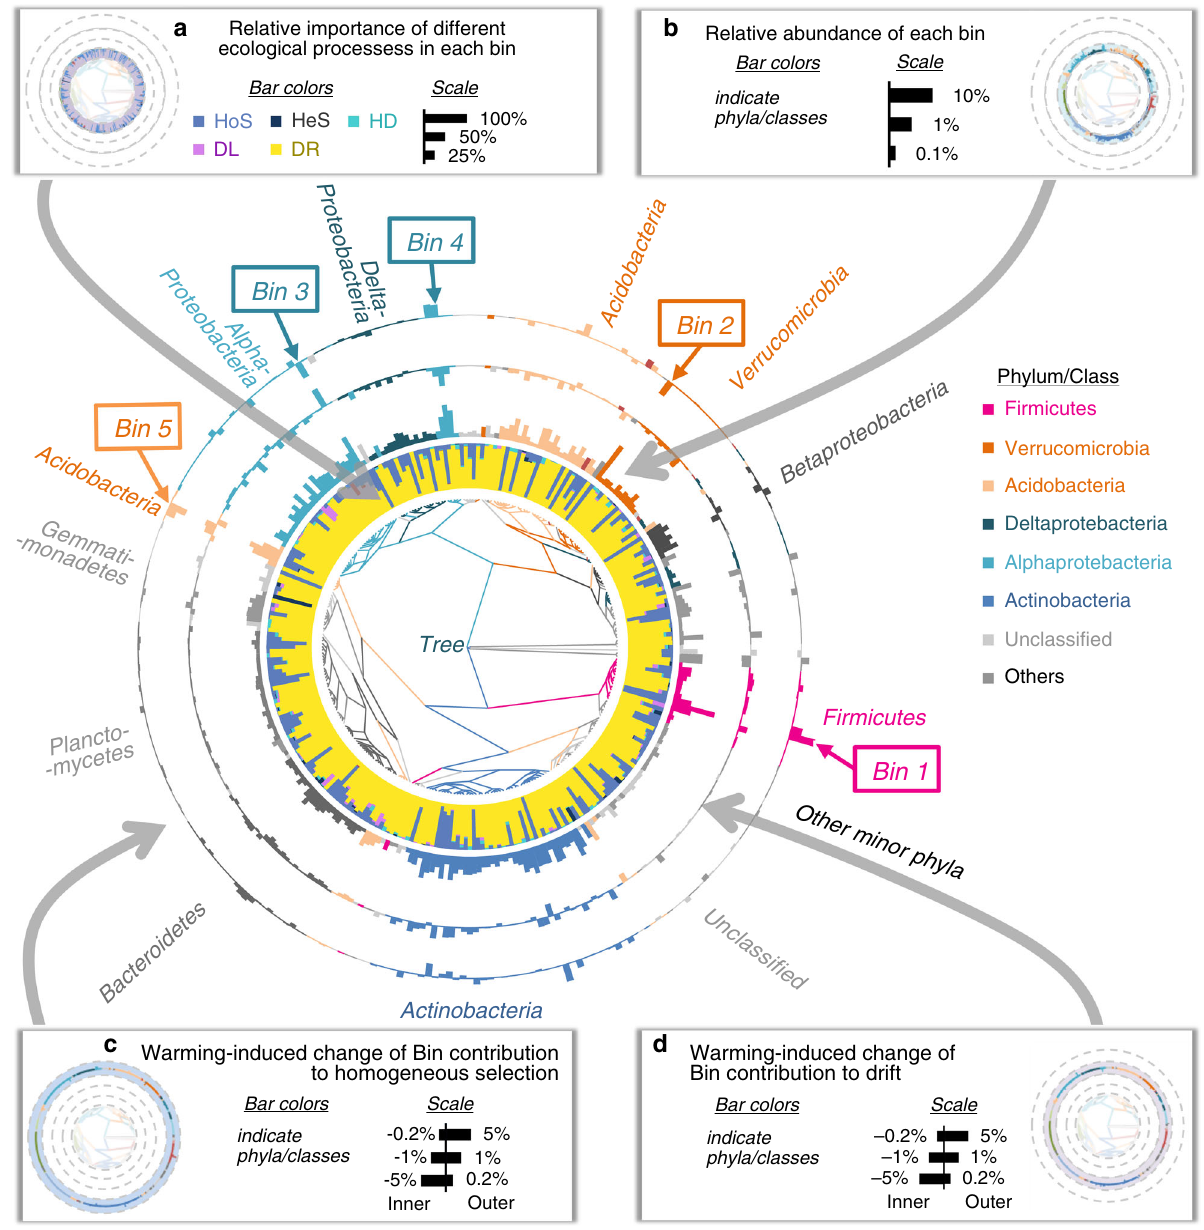
Fig. 4 Variations of ecological processes across different phylogenetic groups. Phylogenetic tree was displayed at the center. a Relative importance of different ecological processes in each bin (stacked bars in fi rst annulus). Light livid bars, homogeneous selection (HoS); dark blue, heterogeneous selection (HeS); turquoise, homogenizing dispersal (HD); violet, dispersal limitation (DL); yellow, drift (DR). b Relative abundance of each bin (2rd annulus). c Warming-induced change in bin contribution to homogeneous selection (4th annulus) and d drift (third annulus) in later 3 years, where positive (outward bar) and negative (inward bar) represented increase and decrease by warming, respectively. Only the top 300 bins were shown in this fi gure, accounting for a total relative abundance of 95%. Bin 1 to Bin 5 were the fi ve most abundant bins. Source data are provided as a Source Data fi